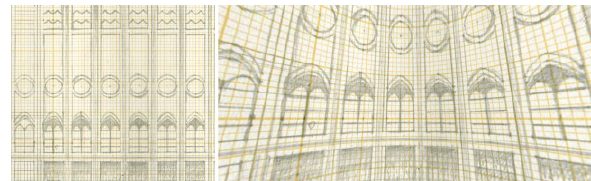
Figure 12 | Left: Author’s sketch of the cylindrical reading room and dome of the British Museum viewed from its axis. Rotational symmetry around the z axis reduces the drawing to a simple tile pattern. Right: Snapshot of the VR